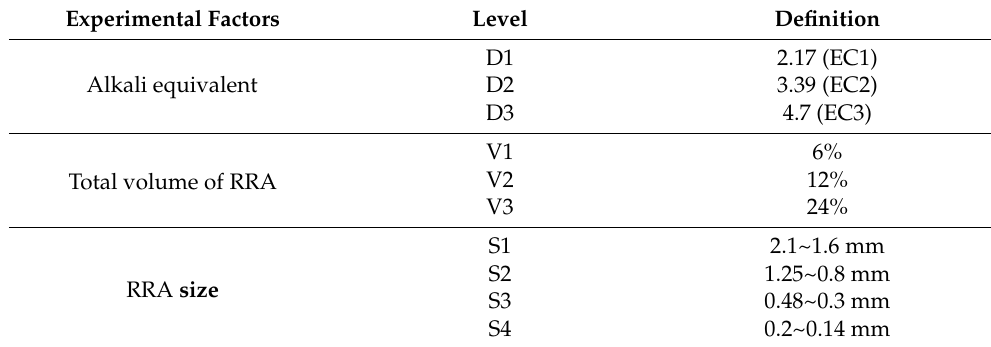
Table 3. Definition and classification of test